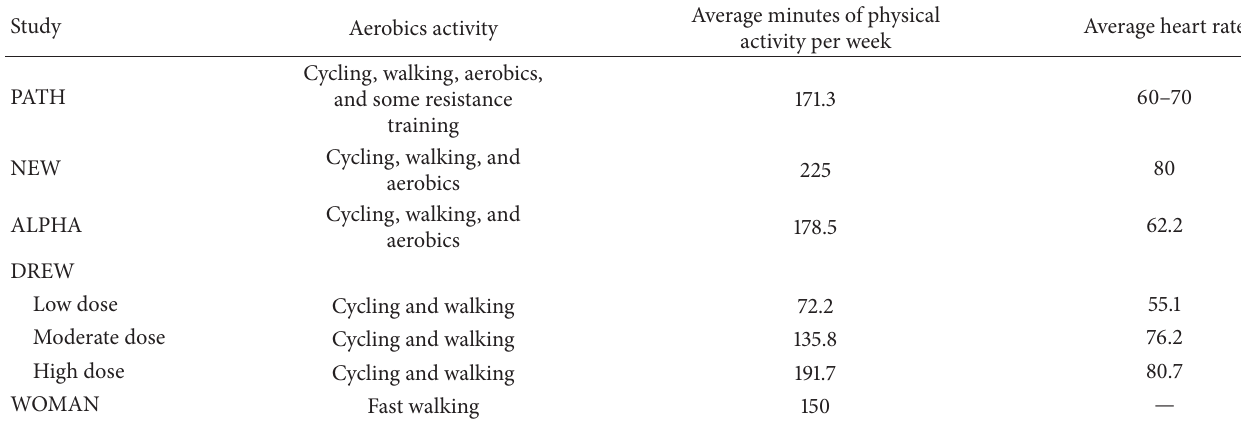
Table 2: Physical activity descriptions and